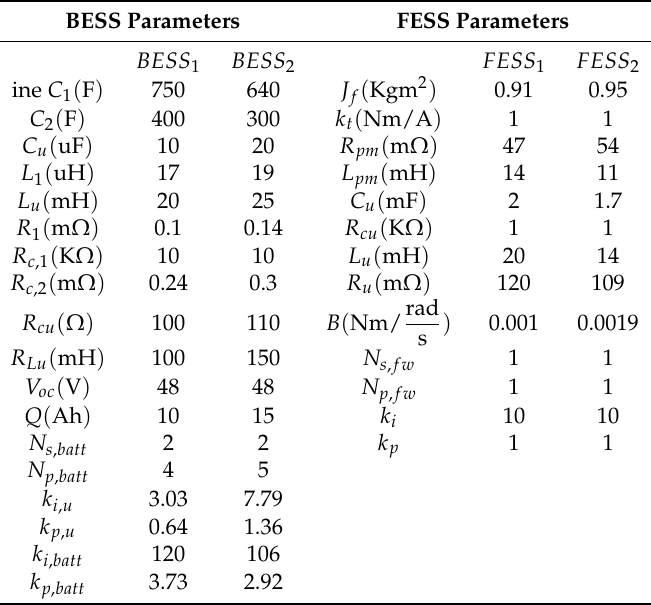
Figure 17. DGU 2 filter system response estimate. Table 2. ESSs